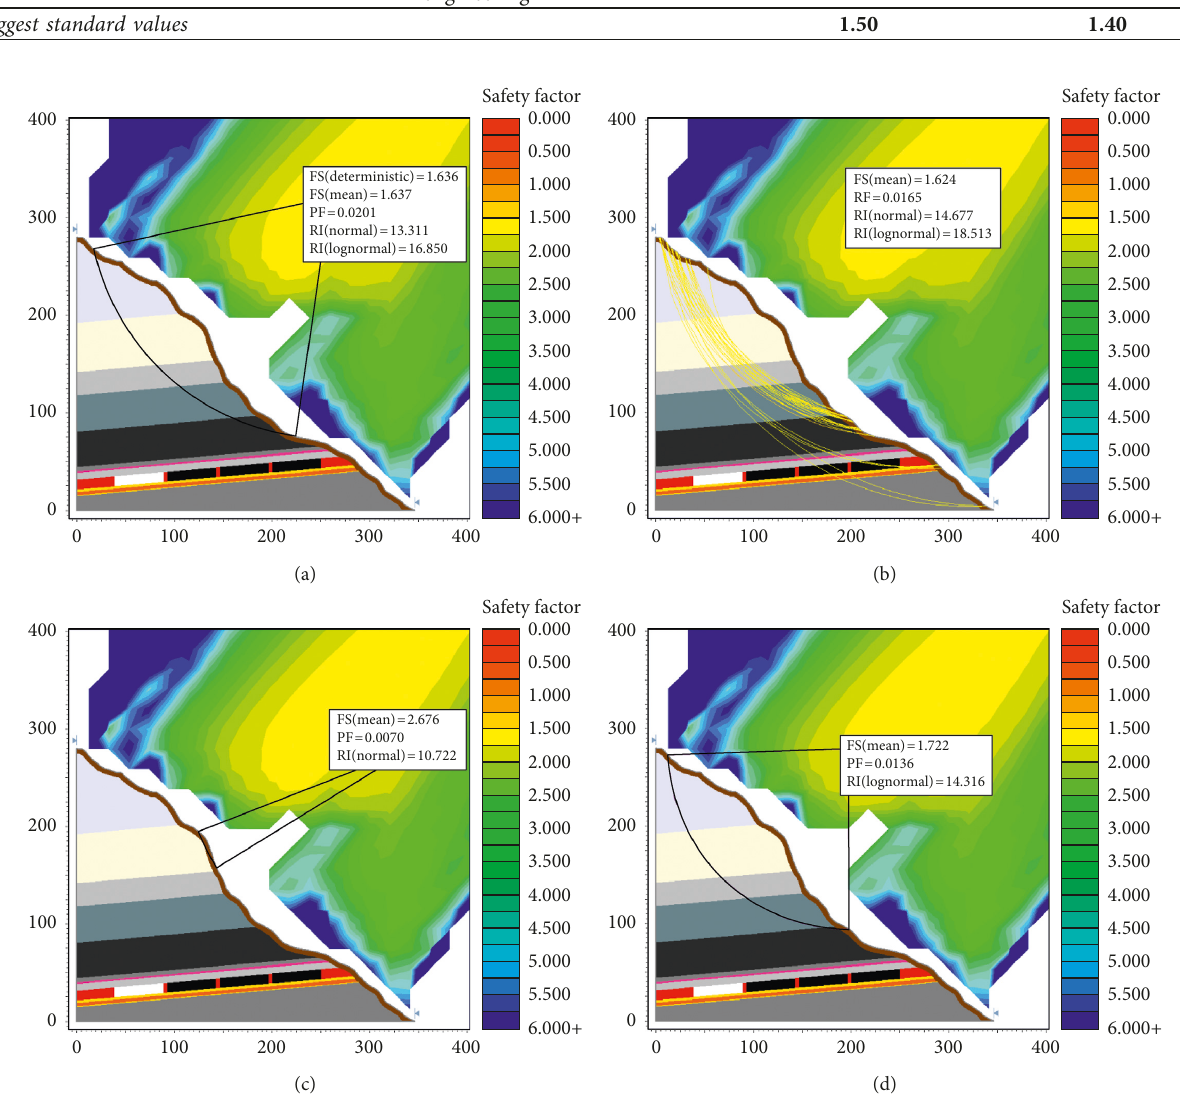
Figure 8: Confidence level analysis results: (a) CDSS; (b) OSM; (c) CPSN; (d)